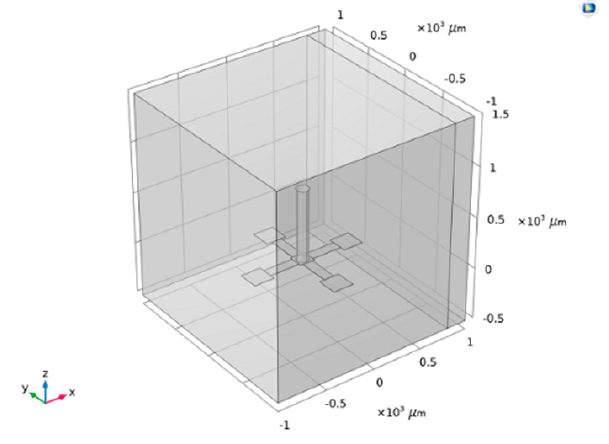
Figure 5. Geometry